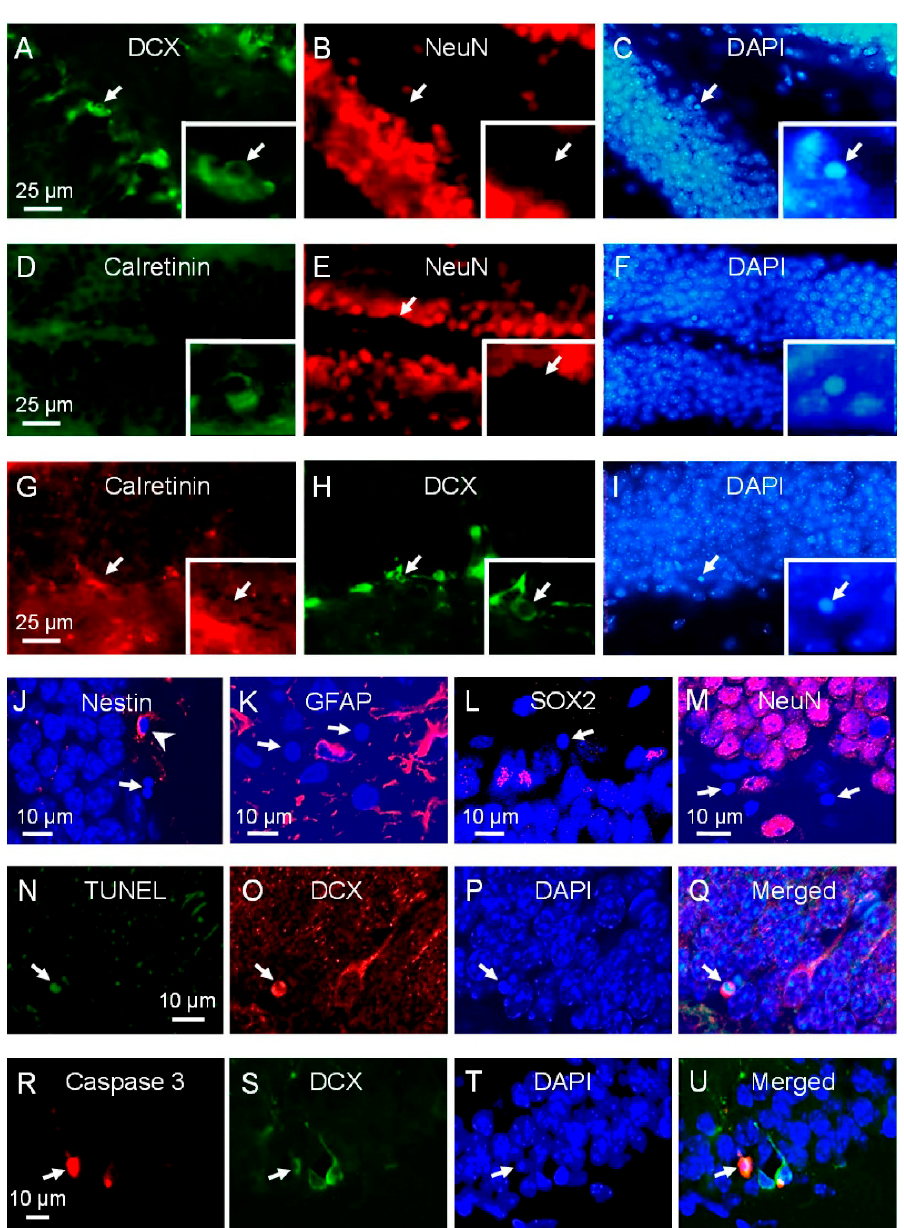
Figure 2. Phenotypic marker expression of apoptotic cells in subgranular zone after irradiation. Apoptotic cells after irradiation demonstrate immunostaining for doublecortin (DCX) and calretinin but not neuronal nuclei (NeuN) (( A – F ), arrows). Some apoptotic cells express both calretinin and DCX (( G – I ), arrows). An occasional apoptotic cell demonstrates immunoreactivity for nestin (( J ), arrowhead), and apoptotic cells negative for glial fibrillary acidic protein (GFAP) (( K ), arrows), SOX2 (( L ), arrow) and NeuN (( M ), arrows) are observed after irradiation. DCX positive apoptotic cells are